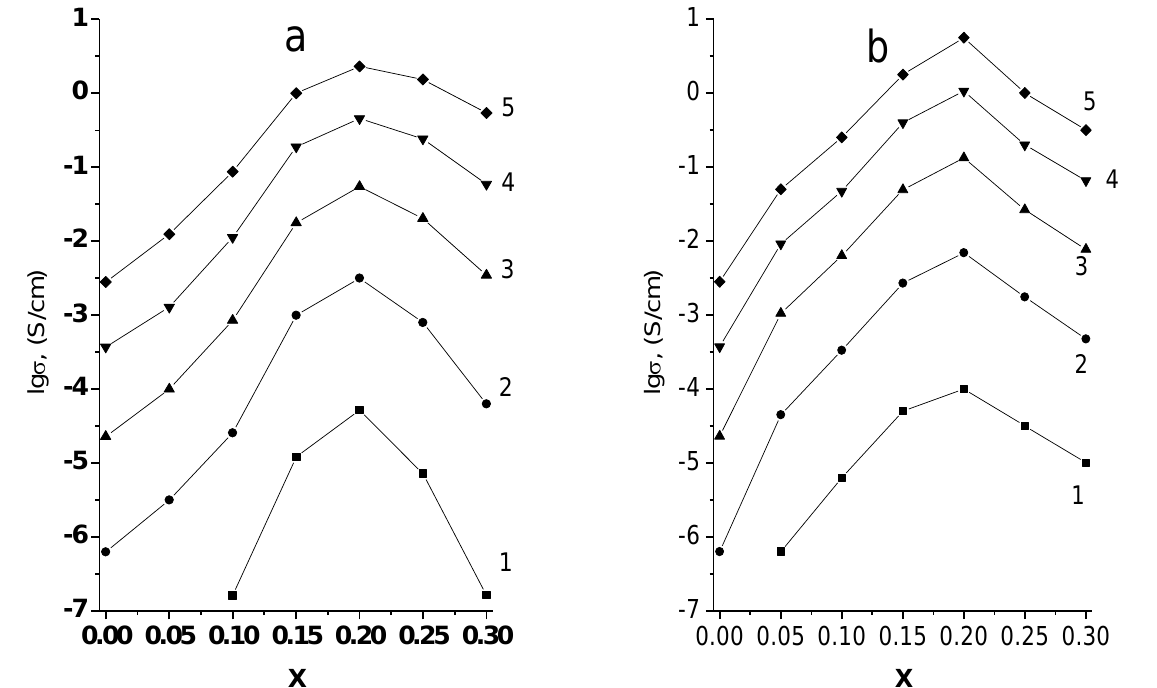
Figure 11. Conductivity isotherms of Li 6-x Zr 2-x A x O 7 A = Nb ( a ), Ta ( b ). 1 – 200; 2 – 300; 3 – 400; 4 – 500; 5 – 600 °C.